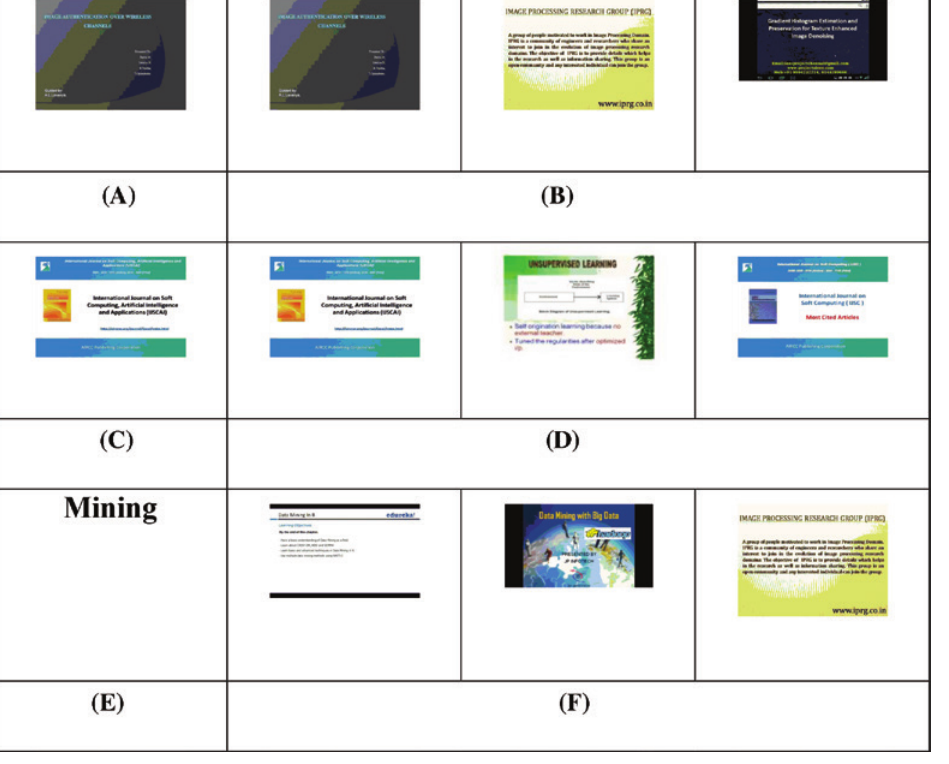
Figure 5: Visualization of Key